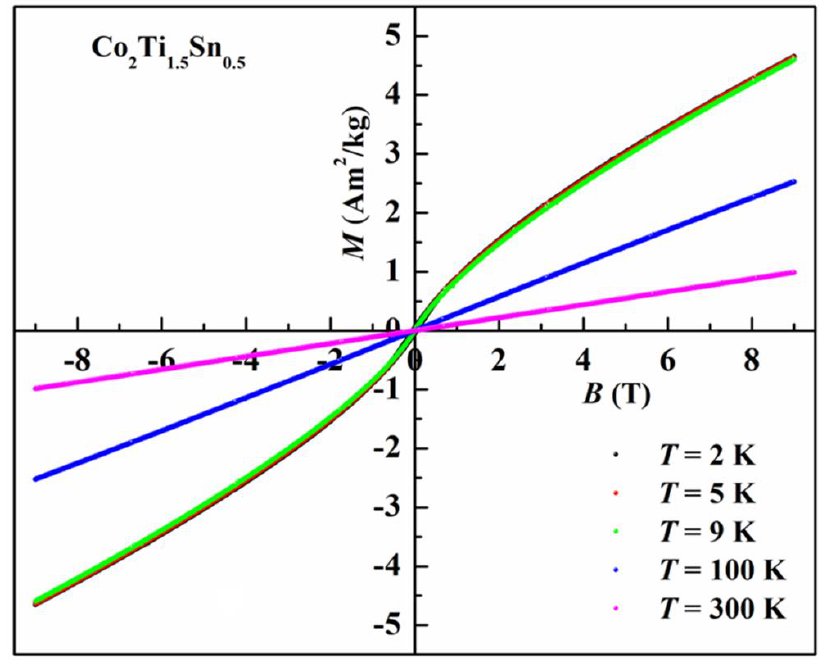
Figure 4. Magnetic hysteresis at selected temperatures ( T = 2 K, 5 K, 9 K, 100 K, and 300 K).